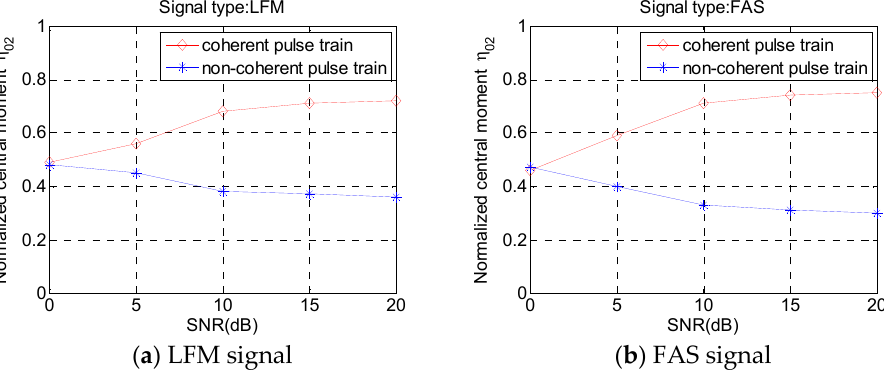
Figure 6. Results of NCM in different SNRs.